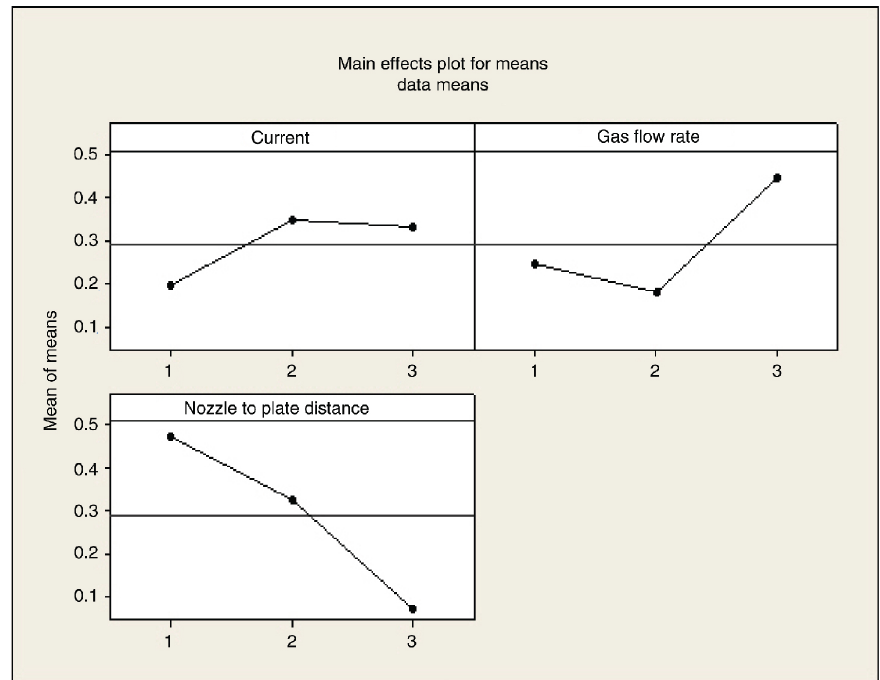
Figure 3: Response graph for mean overall desirability value.